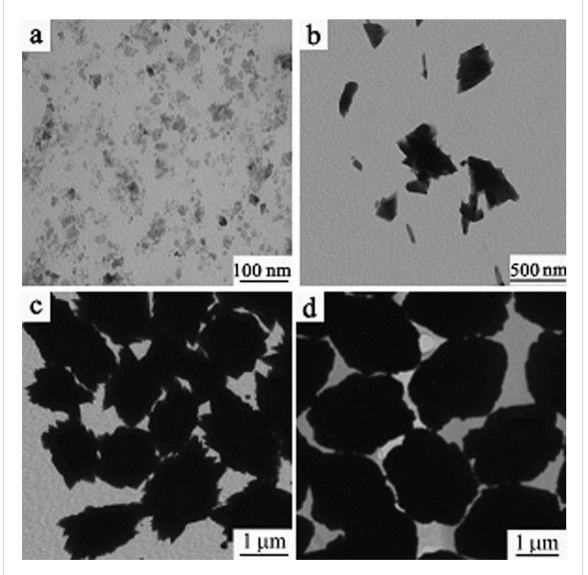
Figure 3: TEM images of precipitated samples formed after addition of the AgNO 3 solution after (a) 2 min, (b) 6 min, (c) 10 min, and (d) 20